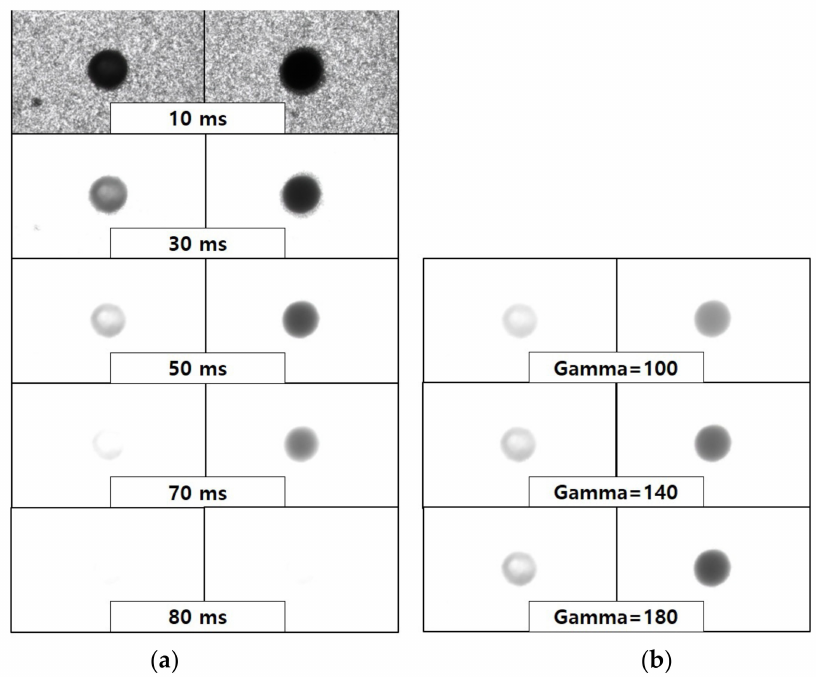
Figure 6. ( a ) Image photograph according to the exposure time of the optical microscope. ( b ) Image picture according to the gamma value.